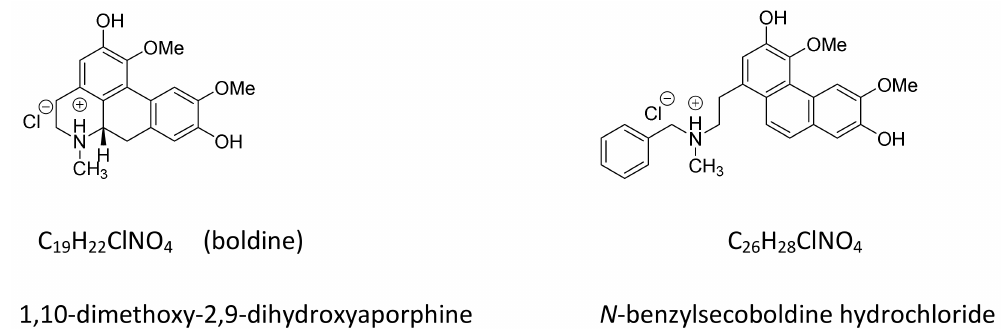
Figure 1. Chemical structures of boldine and N -benzylsecoboldine (BSB)